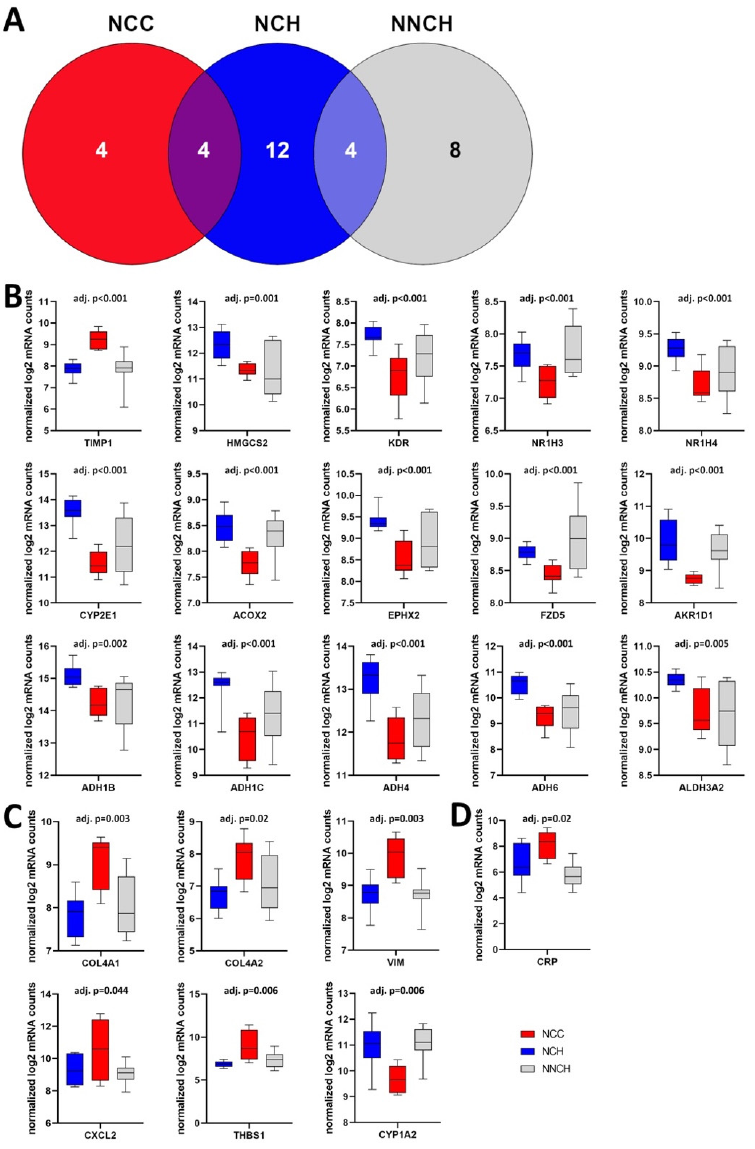
Figure 4. ( A ) Cluster analysis demonstrates a discrimination between the three groups as well as an overlap between those groups with neonatal cholestasis (NCC and NCH) and between those groups with favourable outcome (NCH and NNCH). ( B – D ) Box plots of the most significantly different regulated genes in NCC vs. NCH ( B ), NCC vs. NNCH ( C ) and NCH vs. NNCH ( D ). Whiskers show minimum and maximum distribution. TIMP1 , tissue inhibitor metalloprotease 1; HMGCS2